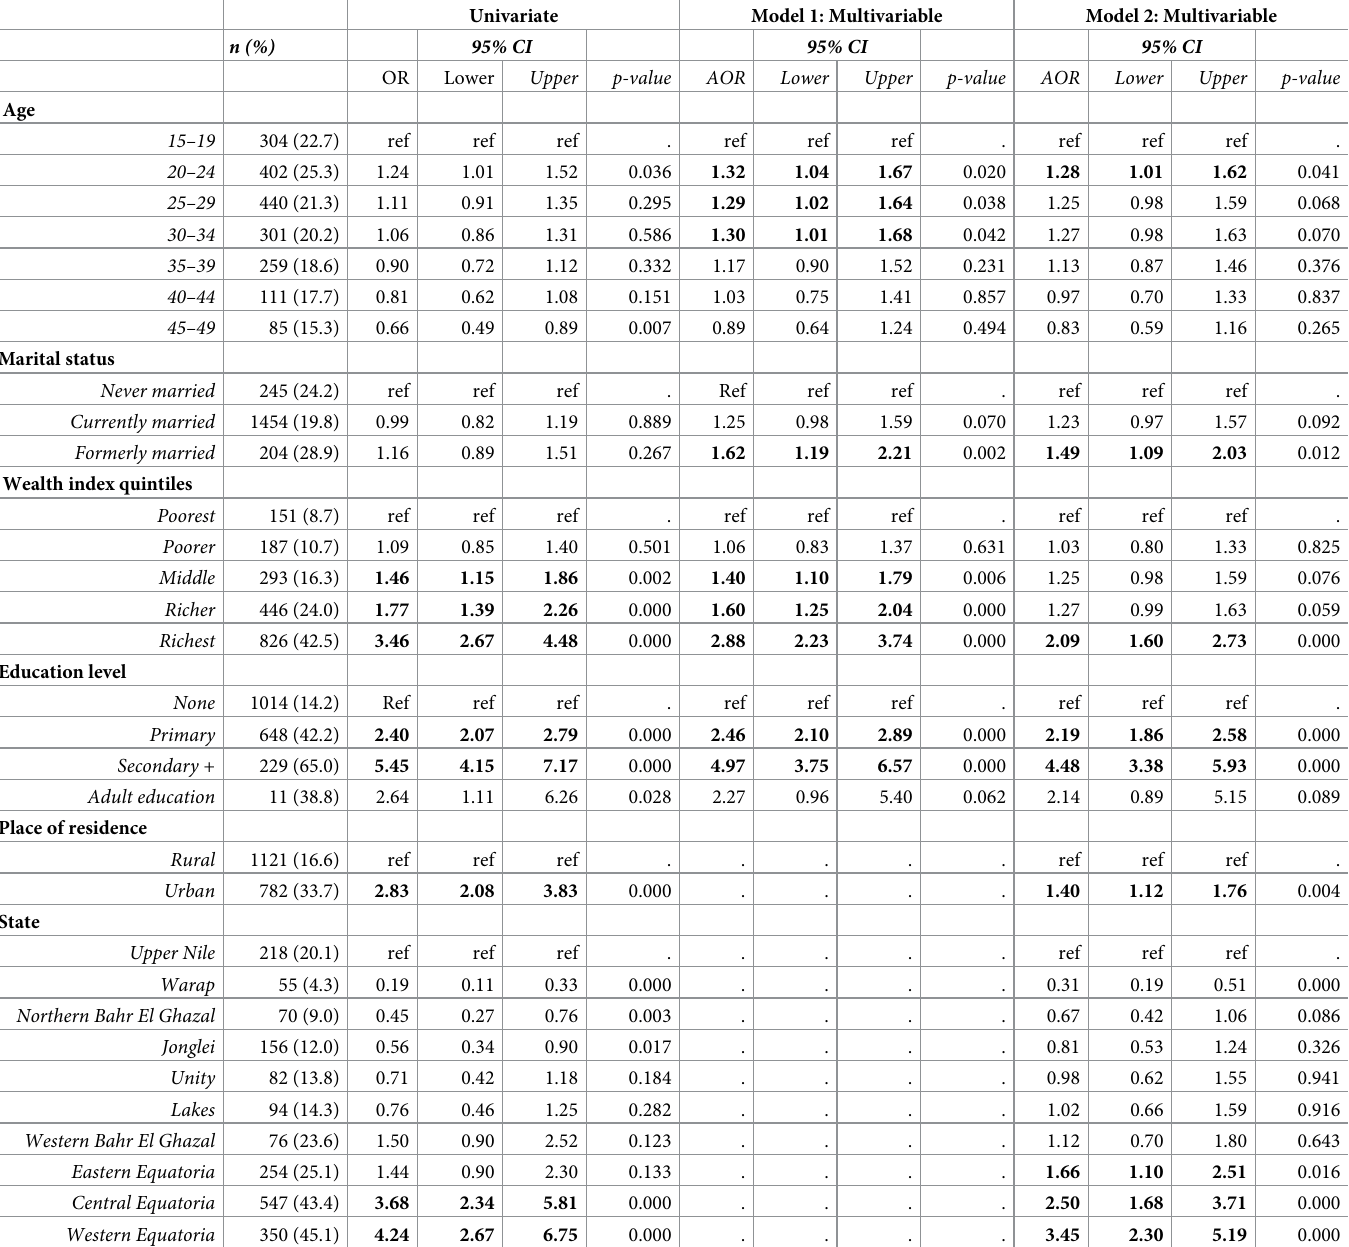
Table 2. Univariable and multivariable binary logistic regression for HIV knowledge (n = 9061) among women in South Sudan. Univariate Model 1: Multivariable Model 2: